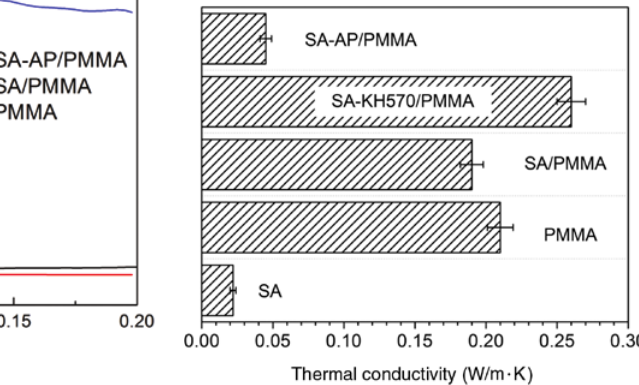
Figure 9: Thermal conductivity of silica aerogel (SA), poly(methyl methacrylate) (PMMA), and